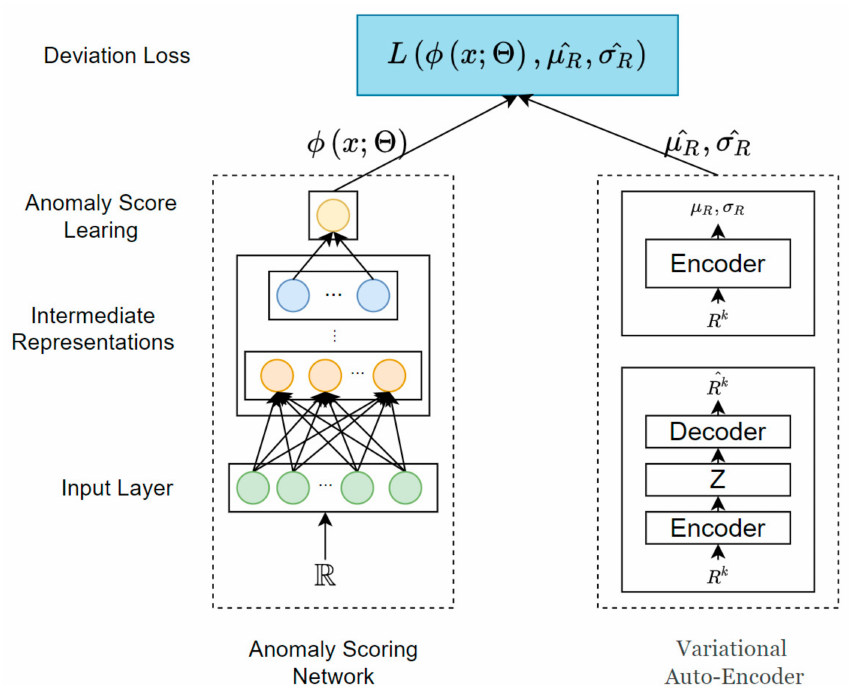
Figure 3. The overall framework of the variational deviation network. φ ( x ; Θ ) is an anomaly score learner with the parameters Θ ; ˆ µ R , ˆ σ R are the reference scores of the training anomaly scores, which are the average mean and average variance of the normal data, where the normal data R k are trained by the encoder in the variational self-coding to obtain the mean and